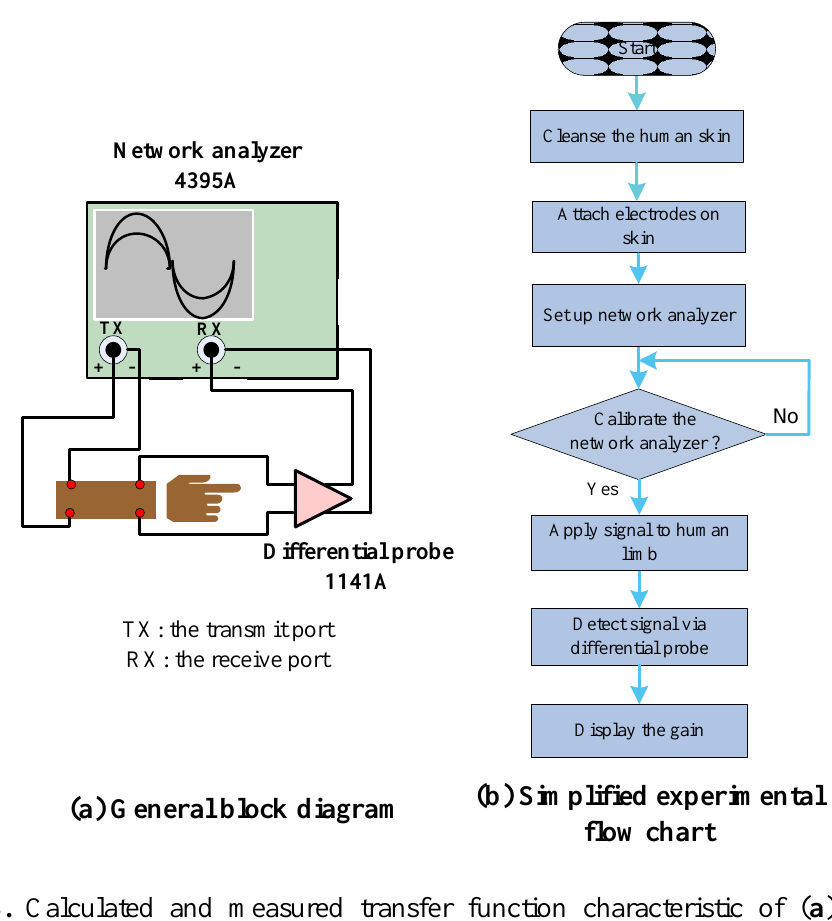
Figure 2. In-vivo IBC channel gain experiment: ( a ) General block diagram and ( b ) Simplified experimental flow chart.